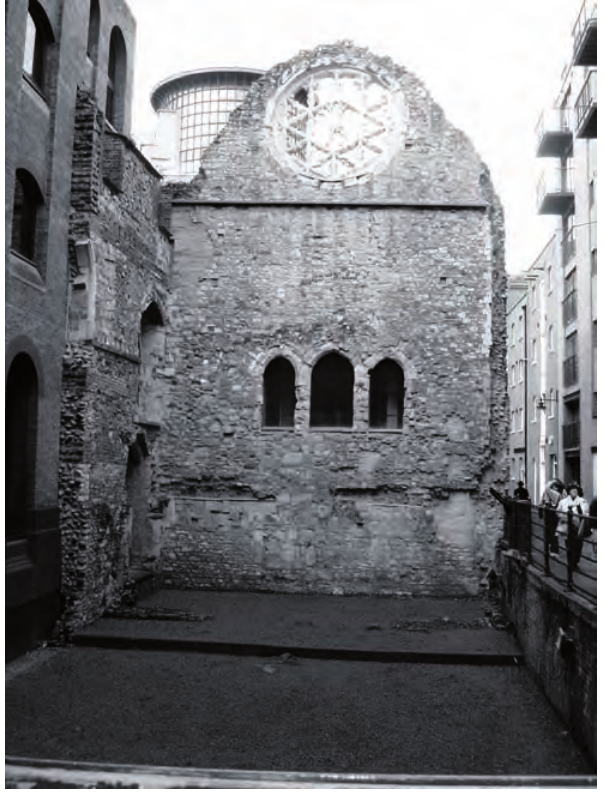
Figure 4. Great Hall, Bishop of Winchester´s Palace, London (Photo by D.